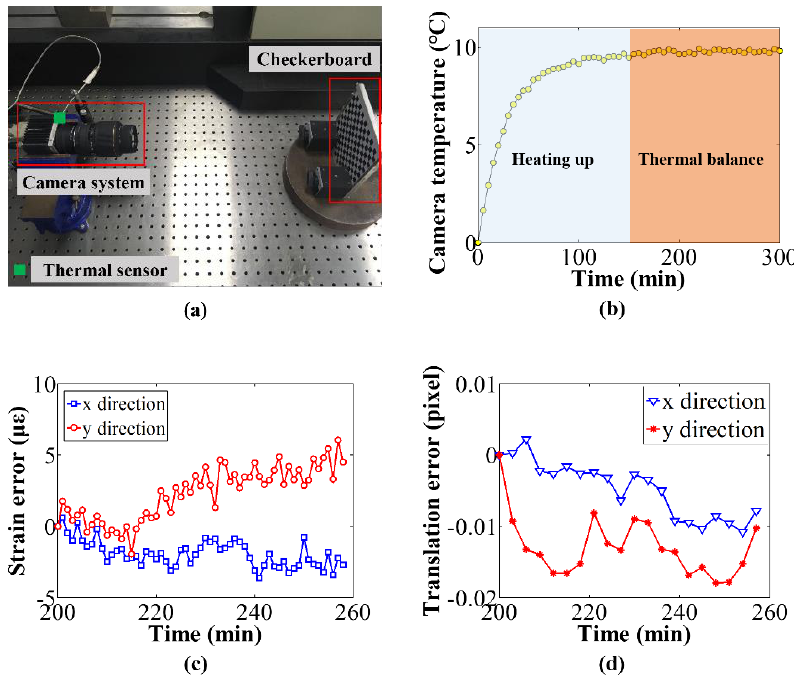
Figure 14. Experimental investigation for avoiding thermal-induced error using the preheating method: ( a ) experimental layout, ( b ) temperature variation of the camera case, ( c ) a thermal-induced strain error, and ( d ) a thermal-induced translation error.